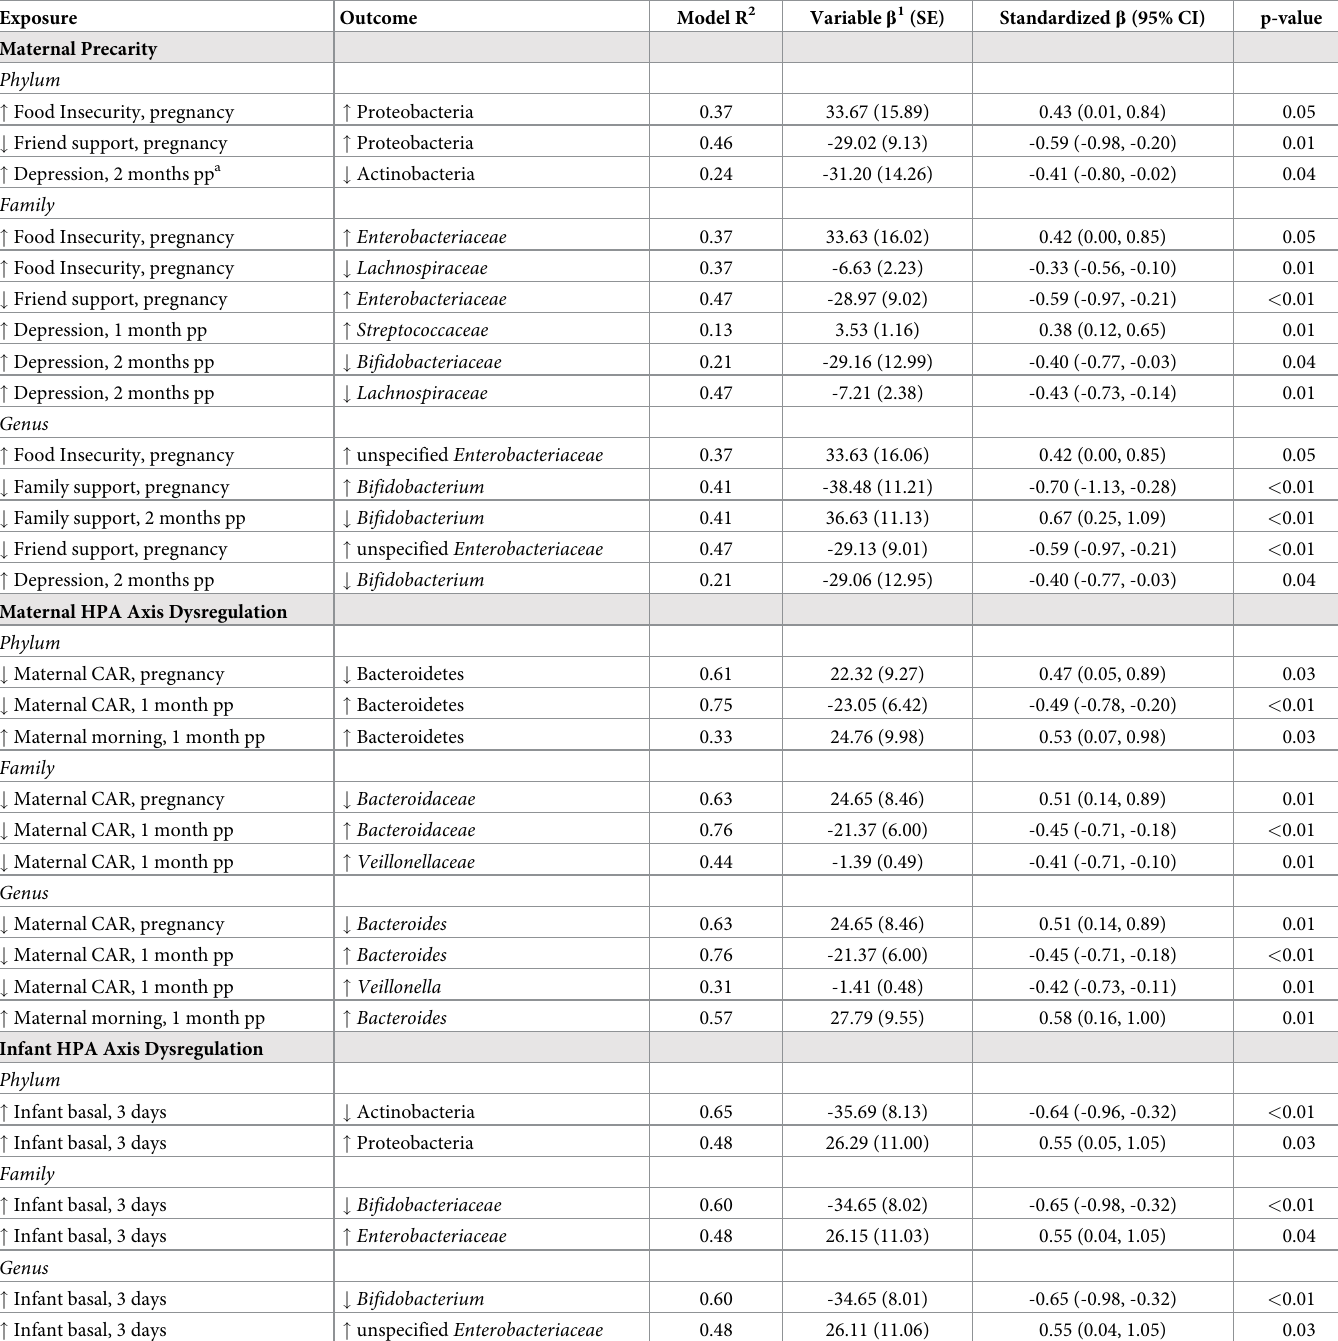
Table 4. Maternal precarity and maternal and infant HPA axis dysregulation are associated with differences in taxa abundance in adjusted